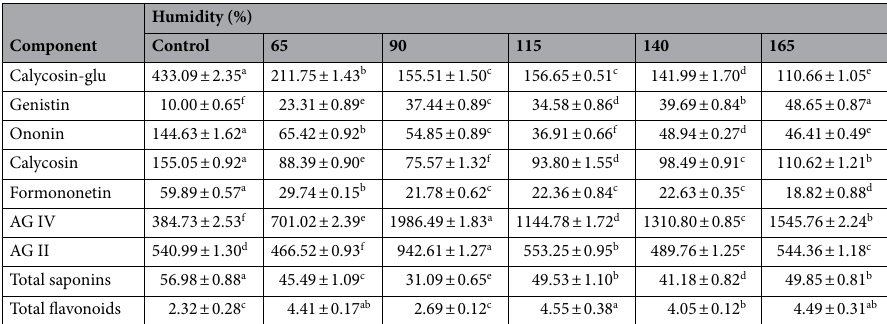
Table 3. Contents of bioactive compounds in humidity. Values are expressed as mean ± standard error from three replications. Means with different superscripts in the same row show significant difference (P < 0.05). Unit of calycosin-glu, genistin, ononin, calycosin, formononetin, AG IV and AG II here is μg/g. Unit of total saponins and total flavonoids here is